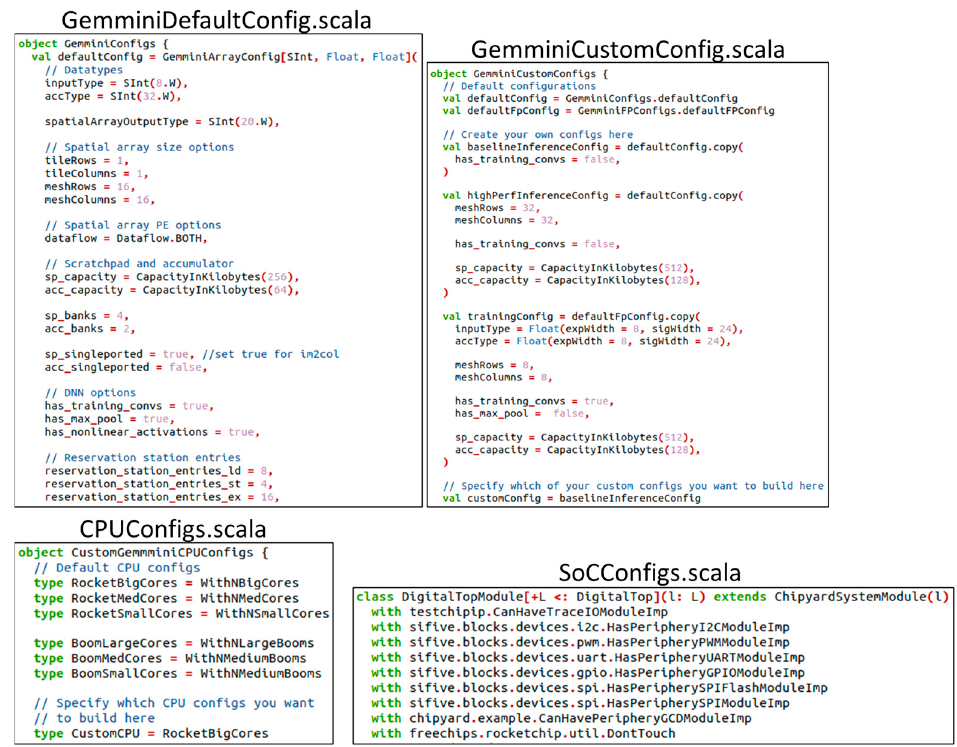
Figure 12. Gemmini SoC generation configuration files.